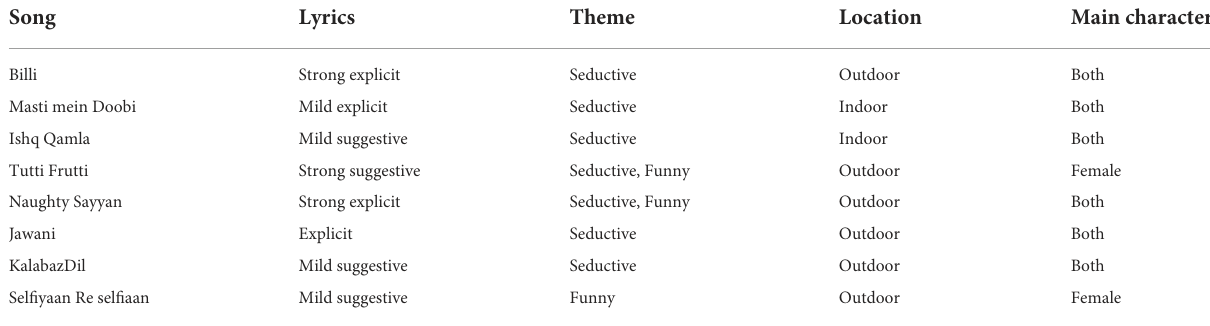
TABLE 5 Lyrics, theme, location, and main character. Song